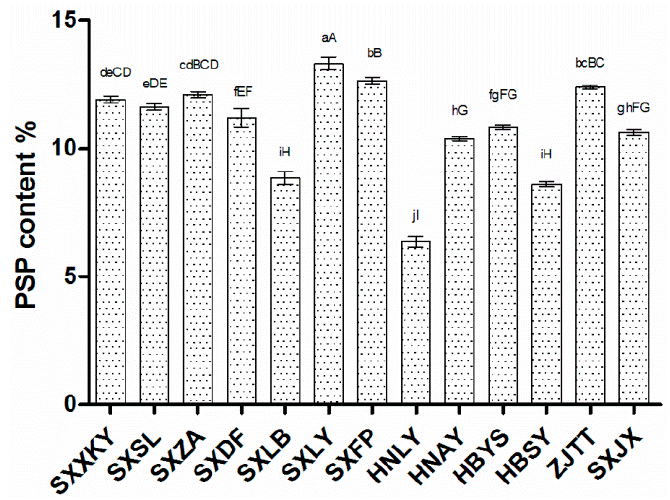
Figure 1. Polygonatum sibiricum polysaccharide (PSP) contents in different germplasms of Polygonatum sibiricum . SXXKY: Xiakou Yi, Shaanxi, China; SXSL: Shangluo, Shaanxi; SXZA: ZhenAn, Shaanxi; SXDF: Danfeng, Shaanxi; SXLB: Liuba, Shaanxi; SXLY: Lueyang, Shaanxi; SXFP: Foping, Shaanxi; HNLY: Luoyang, Henan, China; HNAY: Anyang, Henan; HBYS: Yingshan, Hubei, China; HBSY: Shiyan, Hubei; ZJTT: Tiantai, Zhejiang, China; and SXJX: Jiangxian, Shanxi, China. For the different germplasms, PSP content is significantly different between germplasms at p < 0.05 (different lowercase letters) and p < 0.01 (different capital letters).